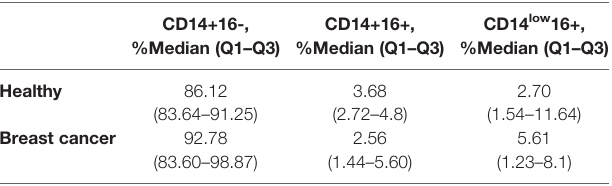
TABLE 1 | Flow cytometry analysis of CD14+16-, CD14+16+, and CD14 low 16+ in healthy female and cancer patients ’